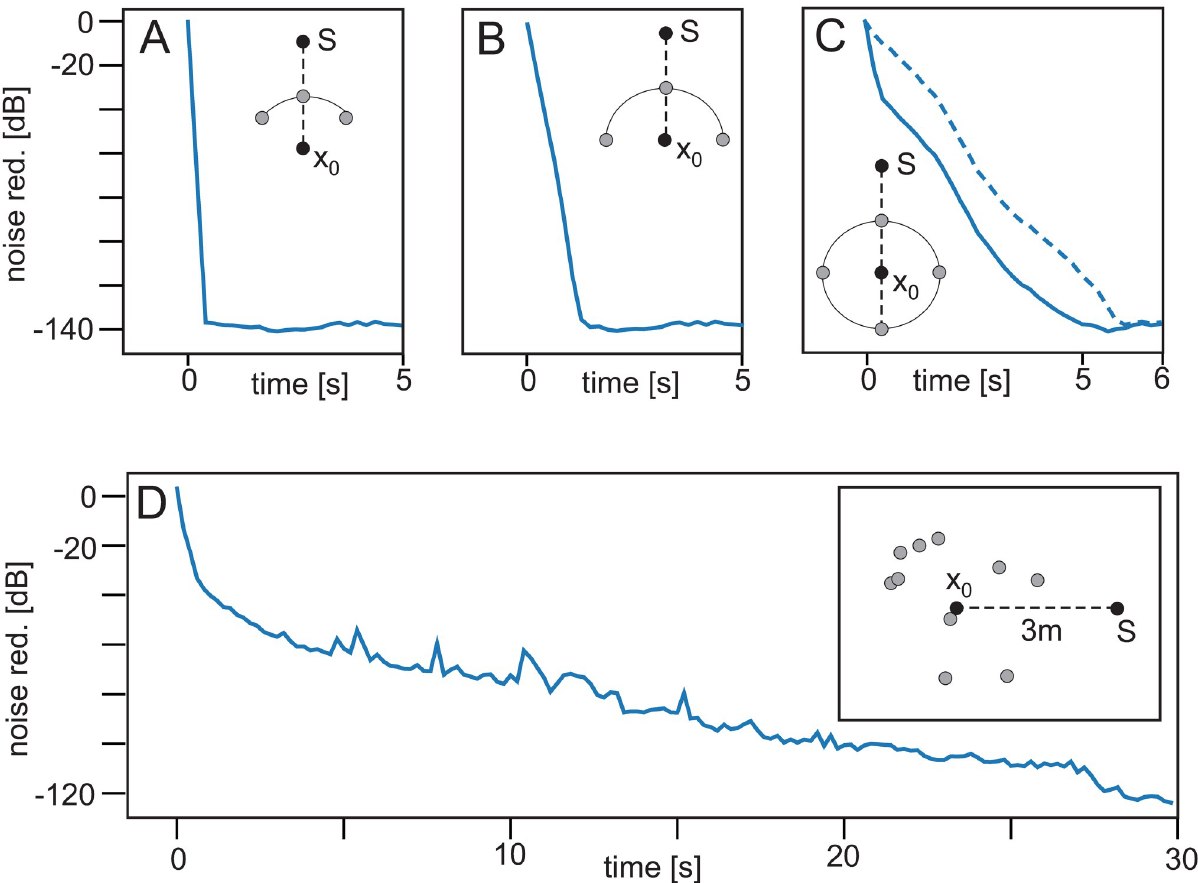
Fig 5. Different microphone configurations. Learning rate μ = 5 × 10 − 7 . A quarter circle, B half circle, A-B with 3 control microphones. C full circle with 4 control microphones, D random configuration with 10 control microphones.